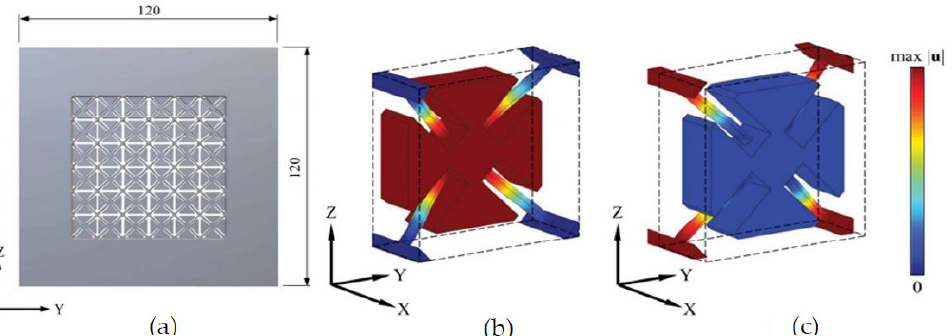
Figure 30. The design of an acoustic metamaterial panel that uses local resonance to attenuate sound, where the panel consists of a 2D array of unit-cells held in place by a solid border. These unit-cells consist of a clover-shaped mass inclusion connected to thin structural supports. The figure shows ( a ) the schematics of the panel design, with dimensions shown in mm, ( b ) the displacement plot of a single meta-cell during attenuation peak at 1050 Hz, and ( c ) the displacement plot of a single meta-cell during transmission peak at 1380 Hz [151]. (Used with permission of American Society of Mechanical Engineers, from [151] [‘Experimental and Numerical Assessment of Local Resonance Phenomena in 3D-Printed Acoustic Metamaterials’, Journal of vibration and acoustics, D. Roca, et al., Volume 142, Issue 2, 2020.]; permission conveyed through Copyright Clearance Center, Inc.).